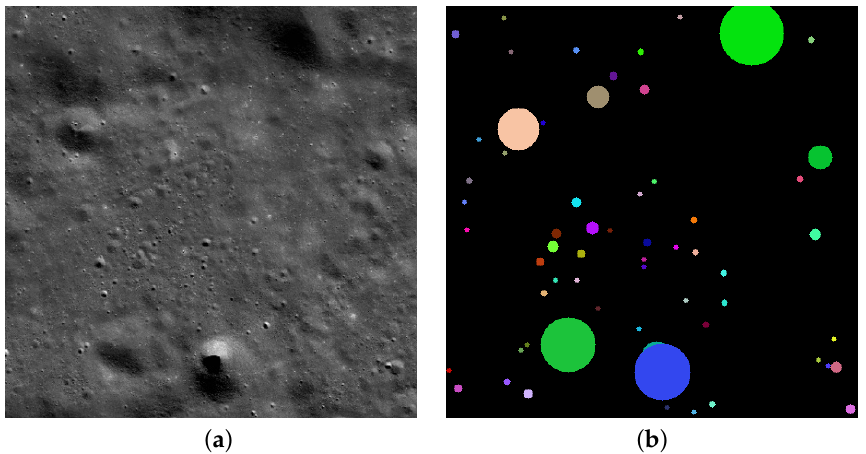
Figure 4. Image and pseudo-color image: ( a ) Original DOM image; and ( b ) labeled crater samples with